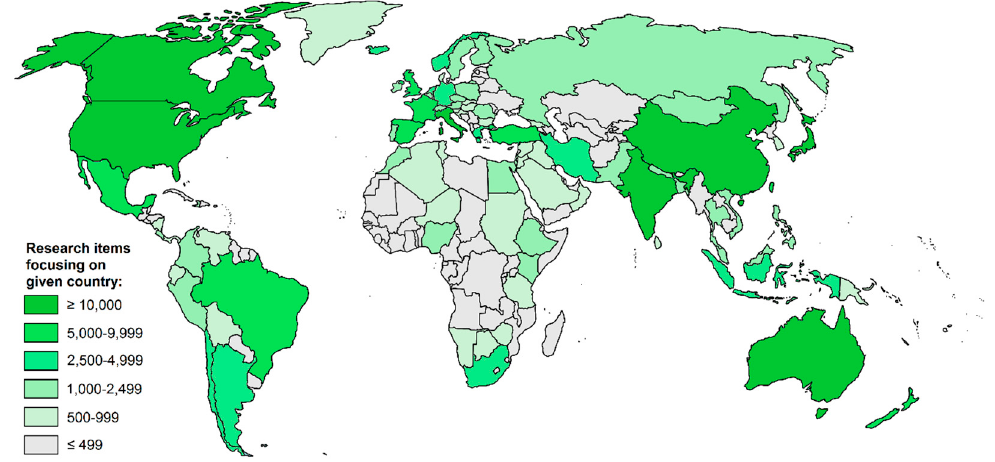
Figure 2. Geographical focus of research on natural hazards.